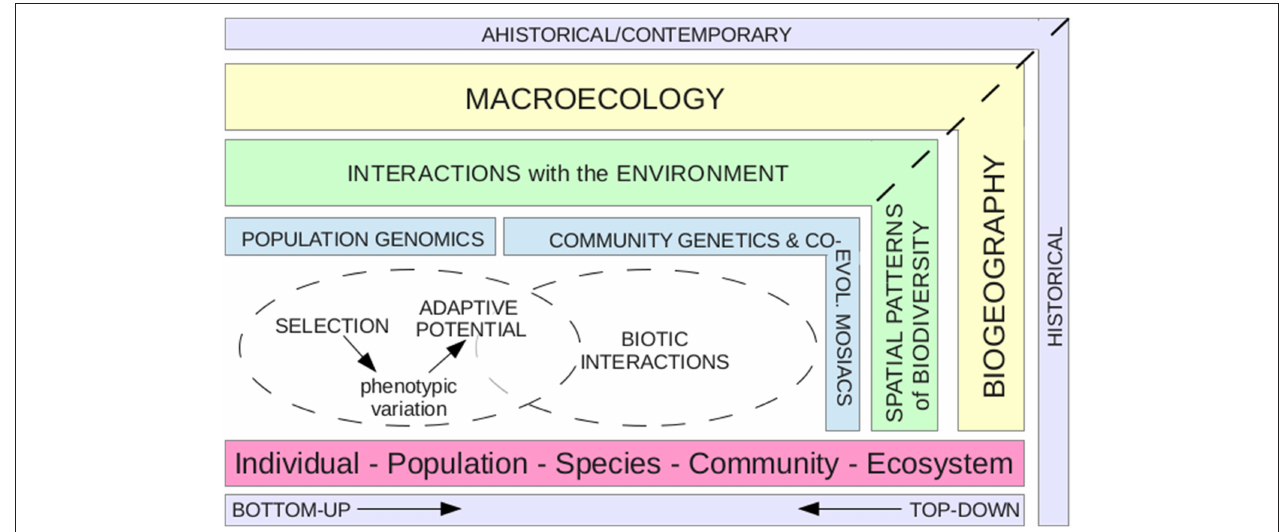
FIGURE 1 | Population genomic data are relevant to systems-level insights. Historically, biogeography and macroecology have been divided on the basis that the former tries to understand spatial patterns of biodiversity, which tends to have an historical focus, while the latter, in studying relationships between organisms and their environment, is generally considered to address contemporary questions. This graphic promotes the idea of incorporating population genomic processes (e.g., selection acting on phenotypic variation to promote adaptive potential), with community genetics and co-evolutionary mosaics (i.e., interactions among populations and their communities, and biotic interactions among populations across regions) into biogeographic and macroecological research. This integrated viewpoint would allow bottom-up approaches to inform top-down questions, by feeding an understanding of processes within populations into an explanation for patterns observed at the